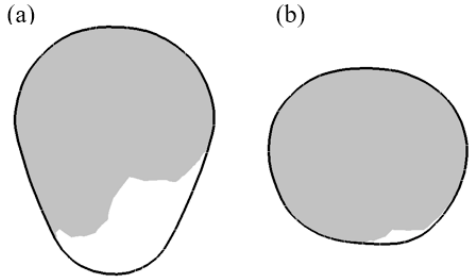
Figure 7. Area enclosed by the boundary line and shaded positive flow area (PFA) at the cross-section (cid:48) at 0.6 s: ( a ) half-moon graft and ( b ) crescent graft. B-B’ at 0.6 s: ( a ) half-moon graft and ( b ) crescent graft. B-B